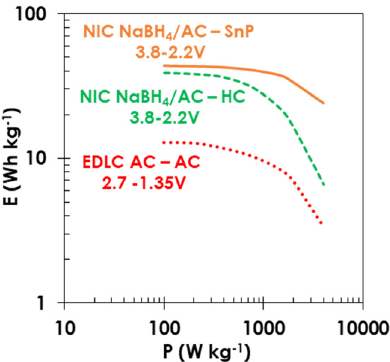
Figure 6: Ragone plots of the NICs prepared with NaBH 4 /AC compo - site - positive electrode and hard carbon ( green dashed line ) or tin phosphide ( orange solid line ) in the voltage range of 2.2 – 3.8 V. For comparison, the EDLC cell data are presented ( red dotted line ) using the same AC as the electrode material, i.e. electrolyte as in NICs and charged up to 2.7